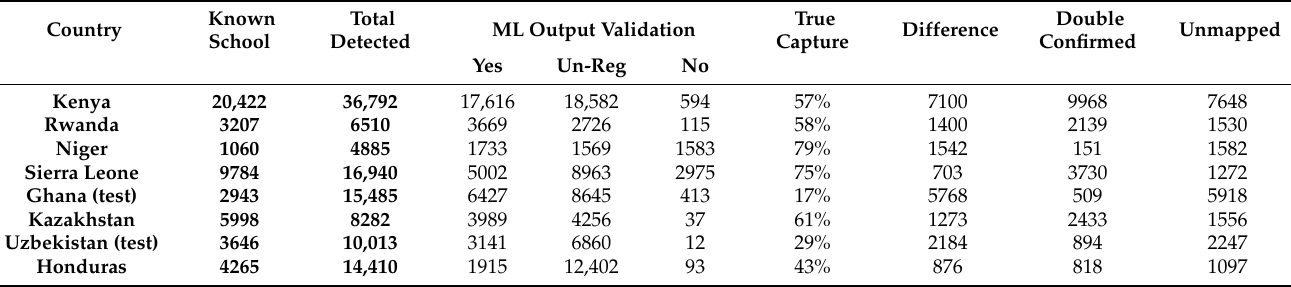
Table 5. Model inference summary across different